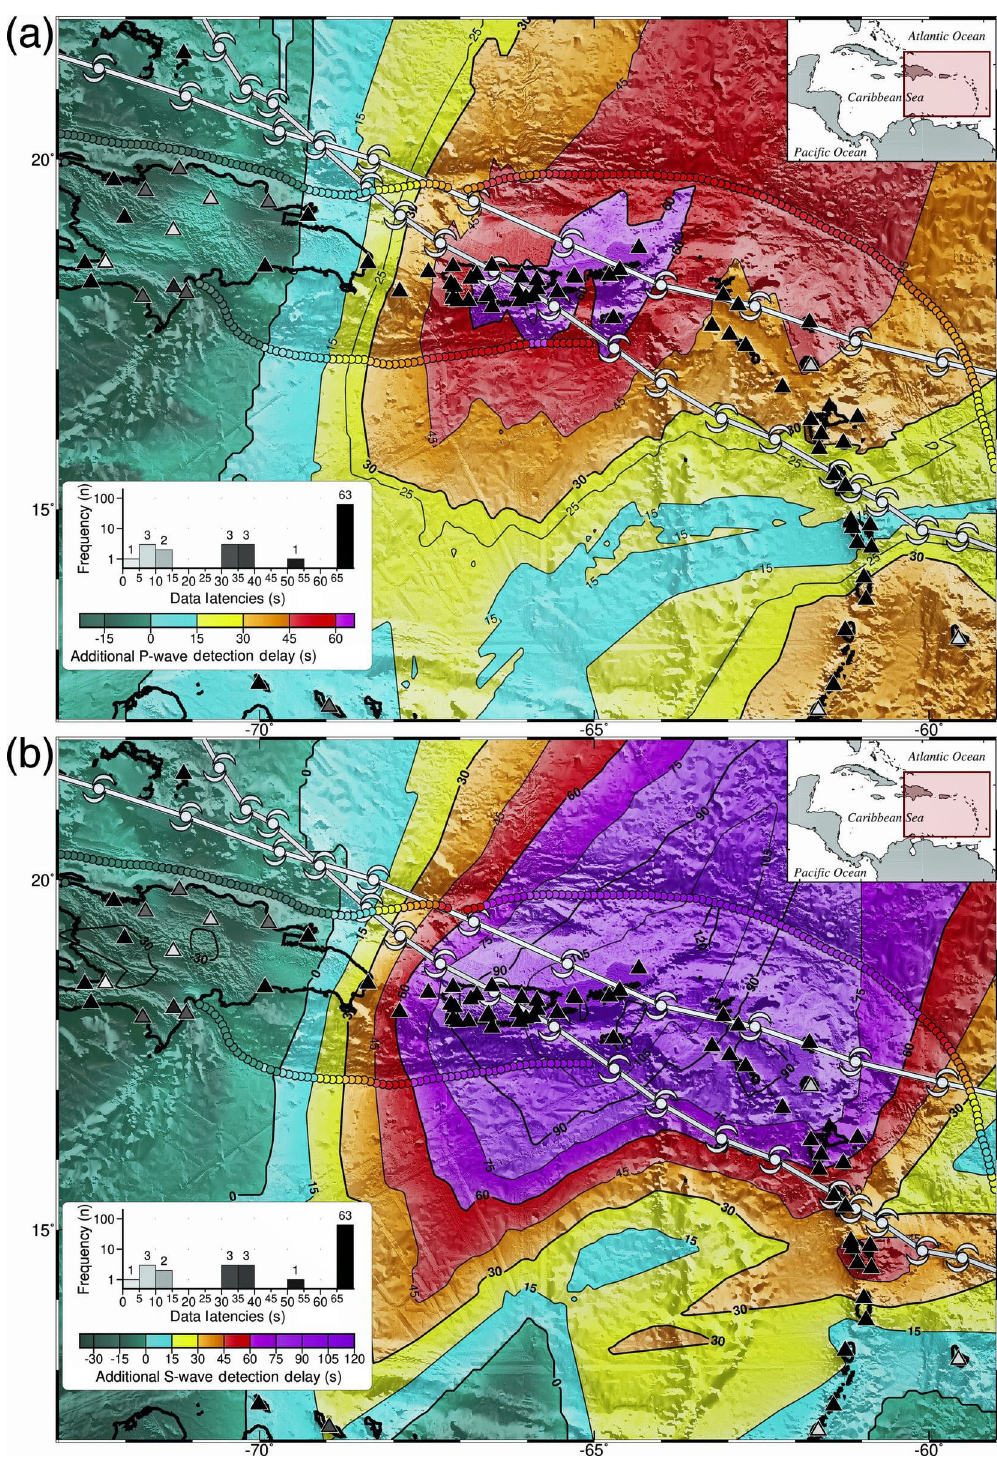
Figure 9. Mitigation of the impact of hurricanes Irma and Maria on the detection time of the first arriving P and S waves by (a) reducing the number of P picks required for event detection to four stations, so that we have additional P wave detection delays with a maximum of 66 instead of the 163s (02:43) shown in Fig. 7b and (b) reducing the number of S picks required for computation and release of a preliminary M L magnitude to two, thereby having additional S wave detection delays with a maximum of 120 instead of the 273s (04:33) shown in Fig. 8b. The small, contiguous circles show the computed P and S wave detection delays sampled every 10km along the trench axes. White vortex tracks show the paths of hurricanes Irma to the north and Maria to the